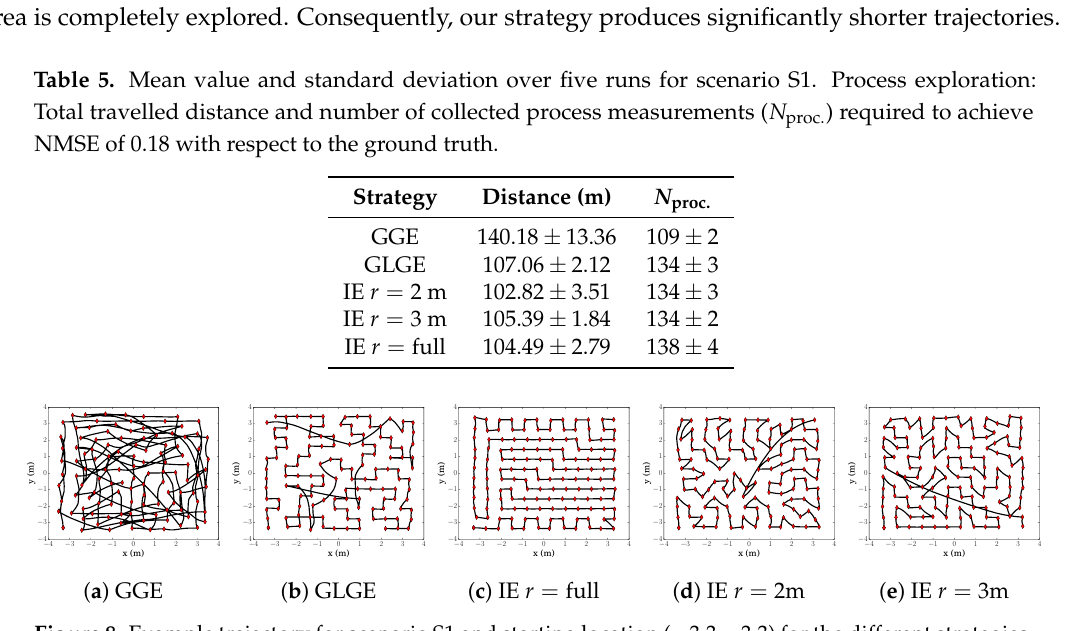
3.3, 3.3) for the different strategies. − −